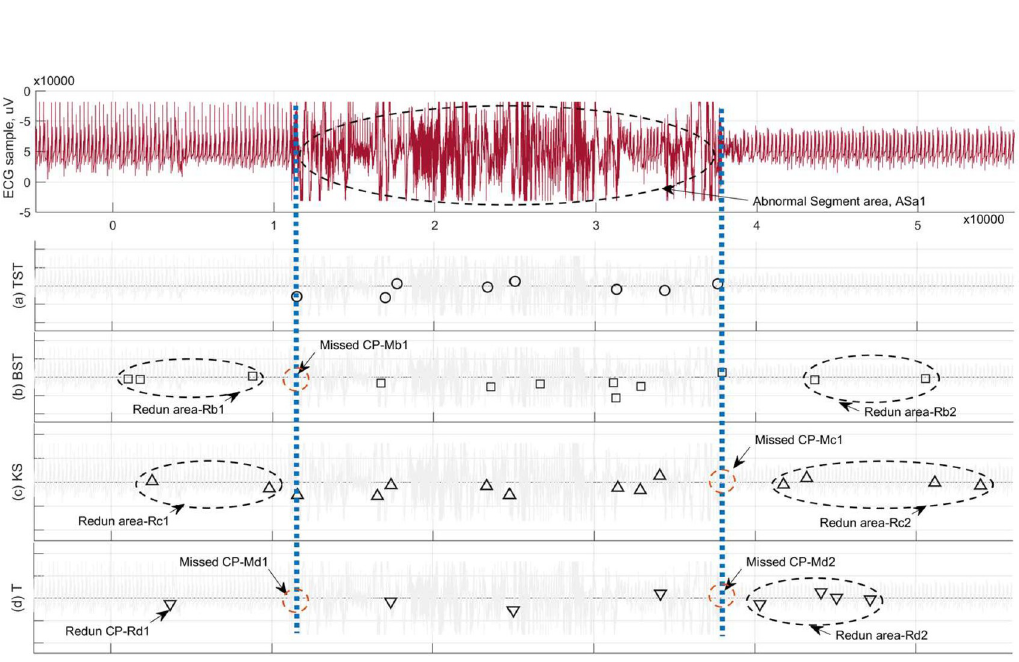
Fig 10. The results of MCPs detection on the same ECG sample used in Fig 9 by means of different methods in the RSW approach. In terms of the partitions of ECG sample, the resultant MCPs are illustrated by using (a) TST, (b) BST, (c) KS, and (d) T methods,